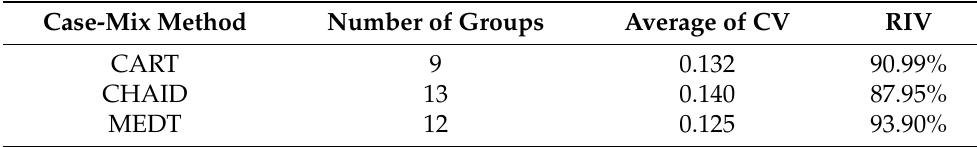
Table 4. CV and RIV values of CART, CARD, and the proposed